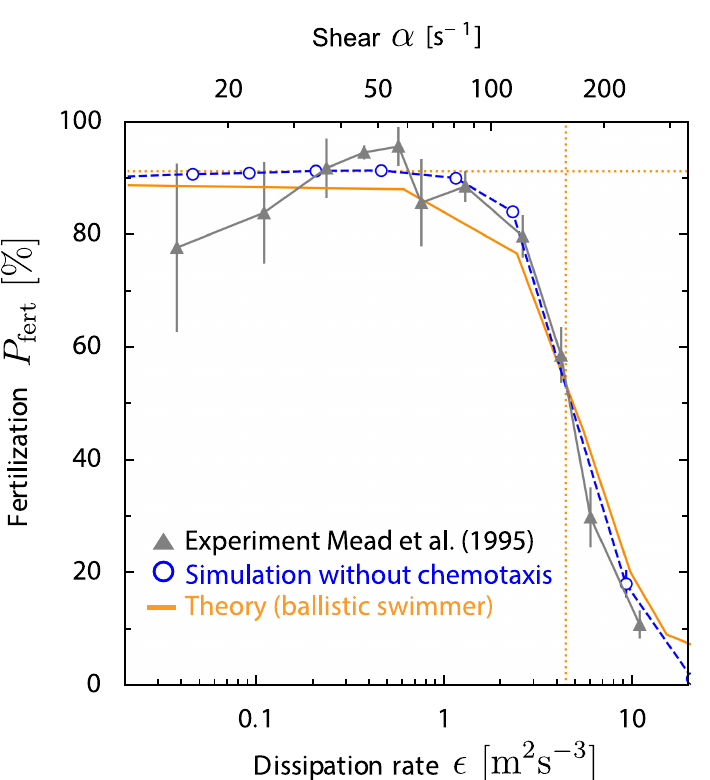
Fig 4. Fertilization in strong flows and high egg density. Previous measurements of fertilization probability P fert ( � ) for sea urchin S. purpuratus at strong turbulence, characterized by density-normalized dissipation rate � (filled gray triangles) [25, 38] and our corresponding simulations P fert ( α ) as function of shear rate α (open blue circles, mean ± SD) match well, using a single fit parameter a = 0.075 that relates dissipation rate � and typical shear rate α ffiffiffiffiffiffiffi p (using the known relationship a ð � Þ ¼ a �= n [24, 26]). Both simulation and experiment are well captured by a minimal theory of a ballistic swimmer in simple shear flow (red), see Sec A in S1 Text. Fertilization probability P fert rapidly drops above a characteristic flow strength α > 100 s − 1 , which is consistent with a scale estimate α = 2 πv h /(0.1 r egg ) (vertical dotted line). At these high shear rates, active swimming becomes negligible compared to convection. The case of low shear rates is well described by the limit case of a ballistic swimmer in the absence of flow r ). The fertilizability α = 0 s − 1 (dotted horizontal line, Eq (5) with P sperm:egg ( t ) = 1 − exp( − qt ) and rate q ¼ p r 2 v h egg egg p f = 10% is obtained from an independent experiment [25], see Fig B in S1 Text. From the experimental protocol, we estimate a high background concentration c bg = 500 − 4000 nM of chemoattractant, which renders sperm chemotaxis ineffective. Corresponding results for simulations with co-rotation are shown in Fig C in S1